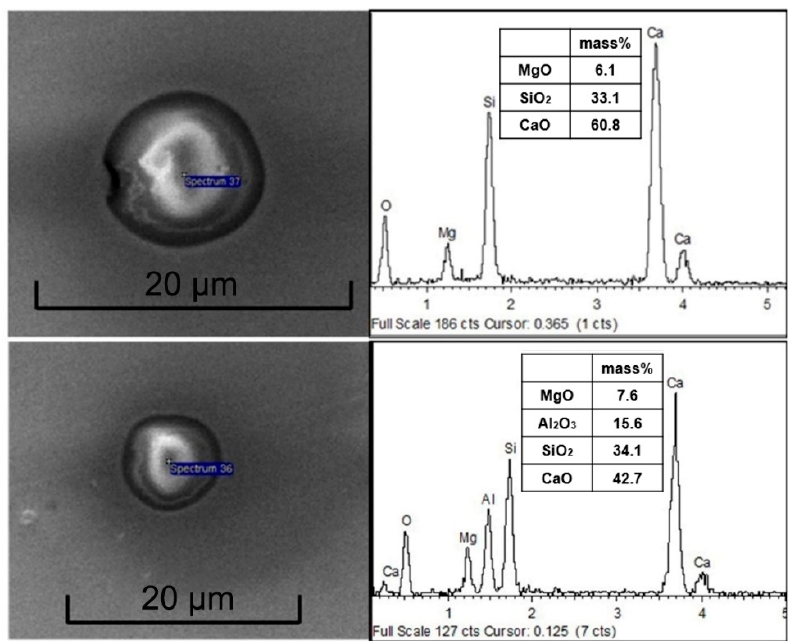
Figure 14. SEM images and EDS results of inclusions in casting slab in the case of calcium addition 3 m/t in LF.